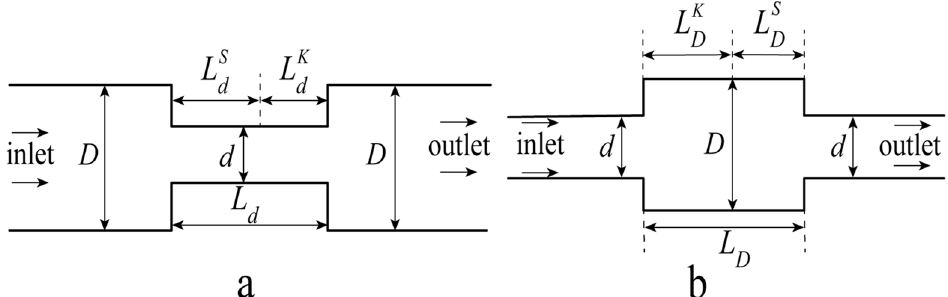
Figure 4. Schematic diagram of pipe diameter reduction–increase and increase–reduction struc ‐